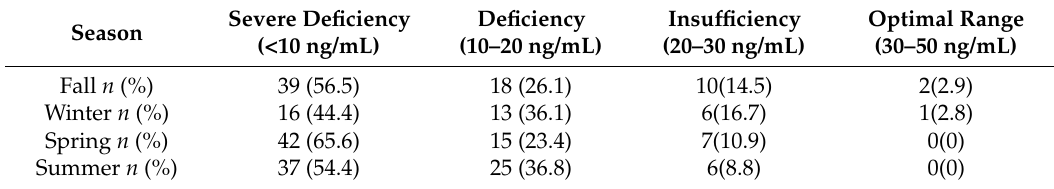
Table 3. The rate of overall vitamin D status in different seasons in the whole cohort. X 2 = 10.055, p = 0.346.